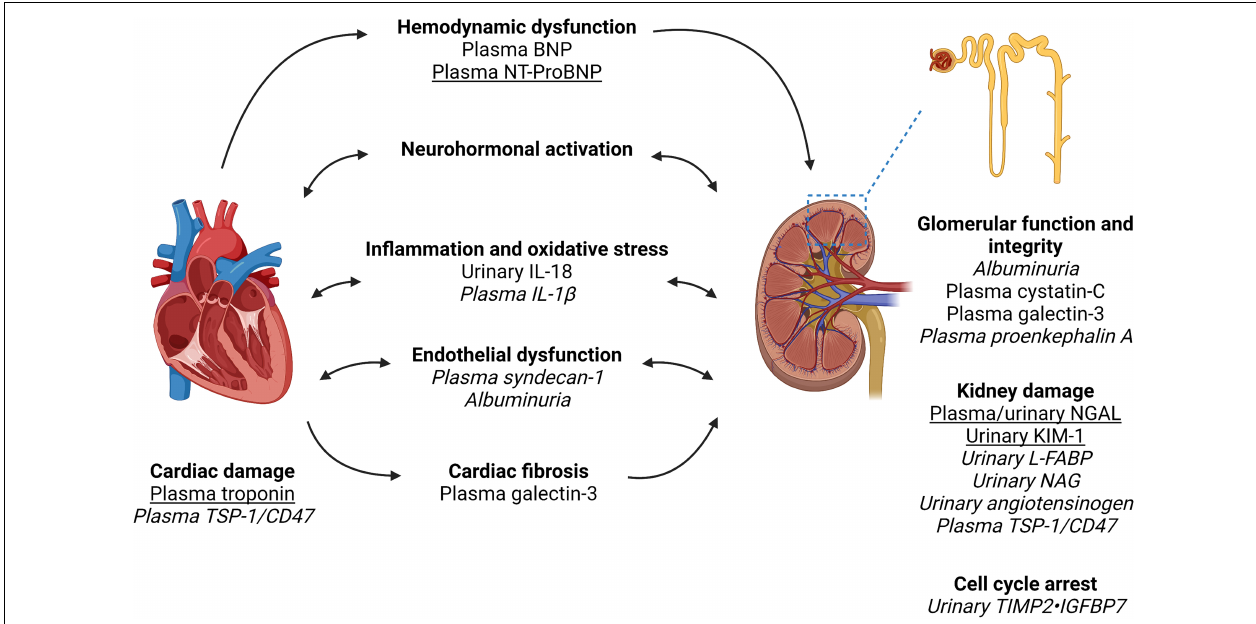
FIGURE 1 | Biomarkers in the pathways of injury in cardiorenal syndrome. Created with Biorender. Cardiorenal syndrome involves the complex bidirectional nature of heart and kidney dysfunction. The pathways involved include hemodynamic dysfunction, neurohormonal activation (primarily the renin-angiotensin-aldosterone system), inflammation and oxidative stress, endothelial dysfunction, and ultimately injury and fibrosis to both heart and kidney. We have outlined the pathways which each biomarker is associated with as well as indicated biomarkers with the most clinical applicability based on the evidence quality of existing literature (underline) vs. biomarkers requiring further research and validation in larger cohort of patients with cardiorenal syndrome (italics). Of note, biomarker performance will depend on kidney function, timing of collection and type of cardiorenal syndrome. Furthermore, a combination of biomarkers may have superior performance to a single biomarker. Therefore, further research is required to identify the type and timing of biomarker(s) analysis in the prediction and prognostication of cardiorenal syndrome. NGAL, neutrophil gelatinase-associated lipocalin; KIM-1, kidney injury molecule-1; L-FABP, liver fatty acid-binding protein; NAG, N- acetyl-beta- D -glucosaminidase; BNP, brain natriuretic peptide; NT-proBNP, N-terminal pro-brain natriuretic peptide; IL, interleukin; TIMP2, tissue inhibitor of metalloproteinases-1 and -2; IGFBP7, insulin-like growth factor-binding protein-7; TSP-1,